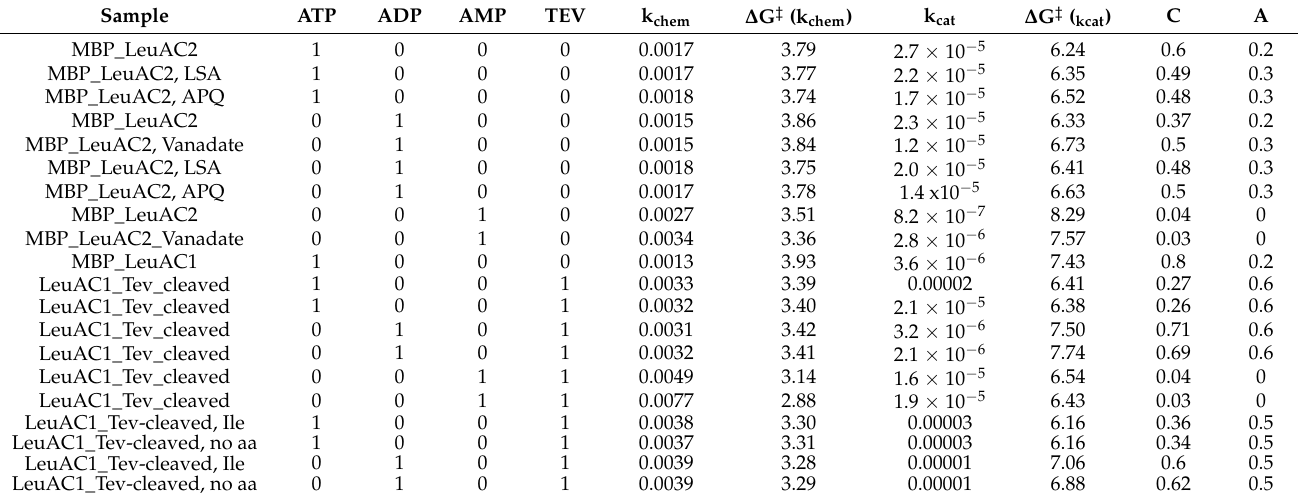
Table 1. Design matrix for dependencies of [ 32 P] ATP active site titrations. Independent variables are [ATP], [ADP], [AMP], TEV cleavage. Dependent variables—k chem , k cat , A, C, and associated free energies—are from fitting to Equation (1). LeuAC1 and LeuAC2 are labelled according to Supplementary Figure